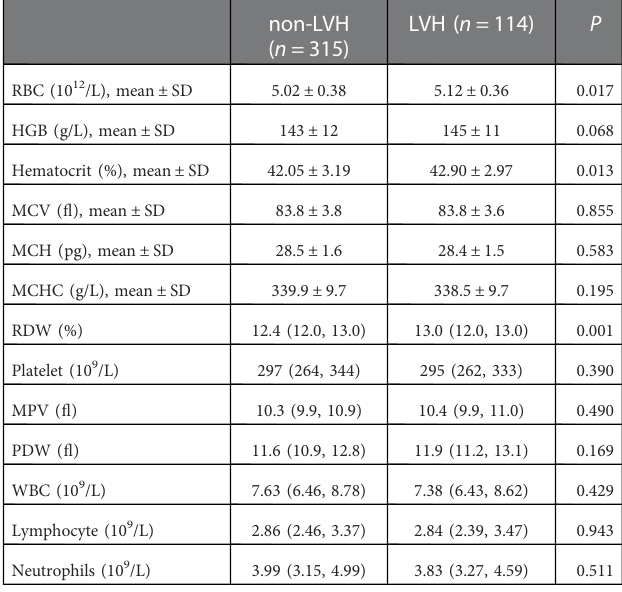
TABLE 3 Complete blood count parameters in LVH and non-LVH group.